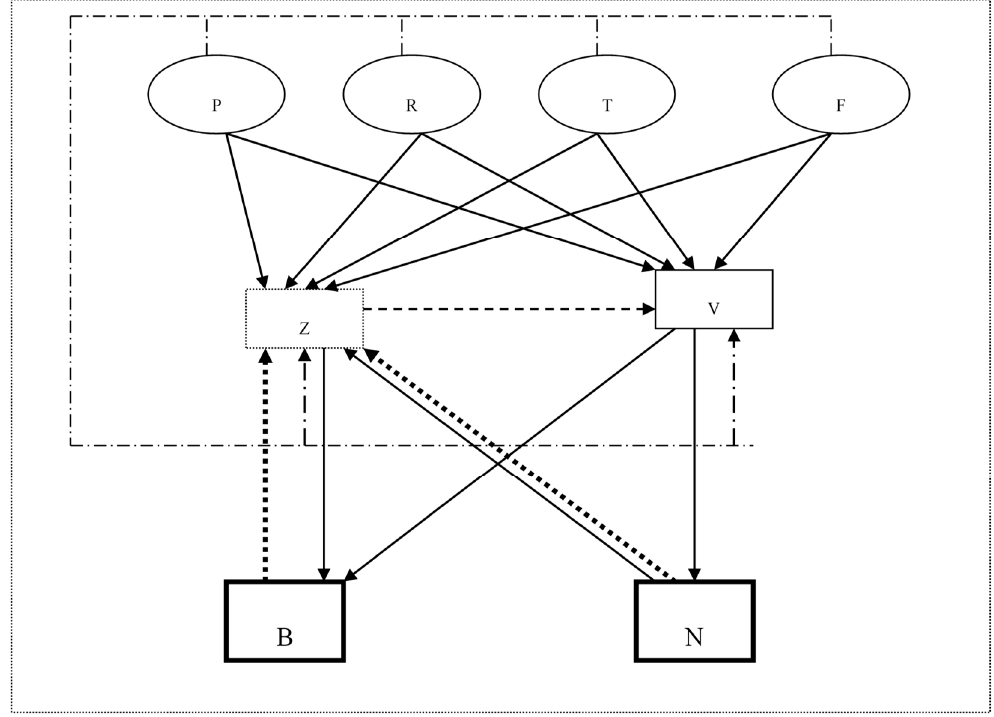
Figure 2. Collecting financial network.